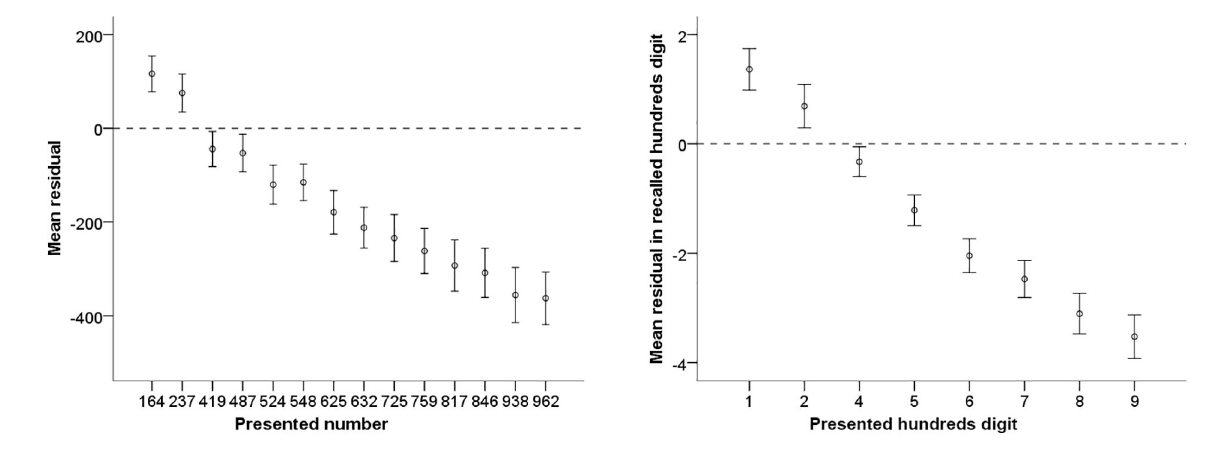
Figure 1. 95% confidence intervals for mean residuals (left) and mean residuals in the leading digit (right). Data from Thompson and Siegler